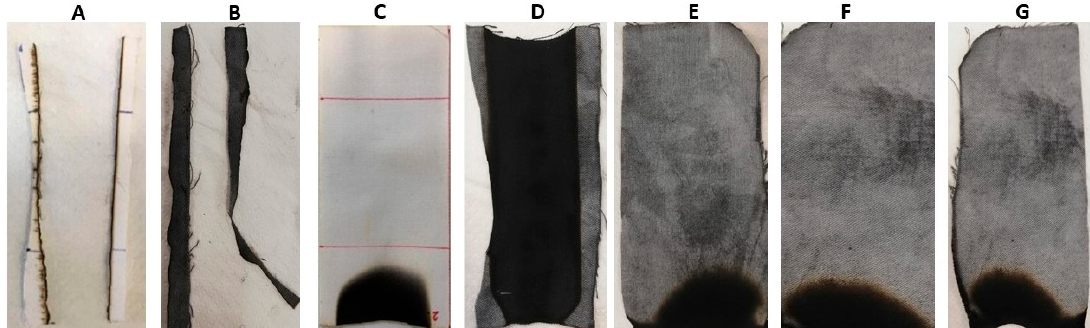
Figure 6. Residues after horizontal flame spread tests. ( A ) COT, ( B ) COT + BC, ( C ) COT + PA, ( D ) COT + PA + BC(4), ( E ) COT + PA + BC(6), ( F ) COT + PA + BC(8), ( G ) COT + PA +